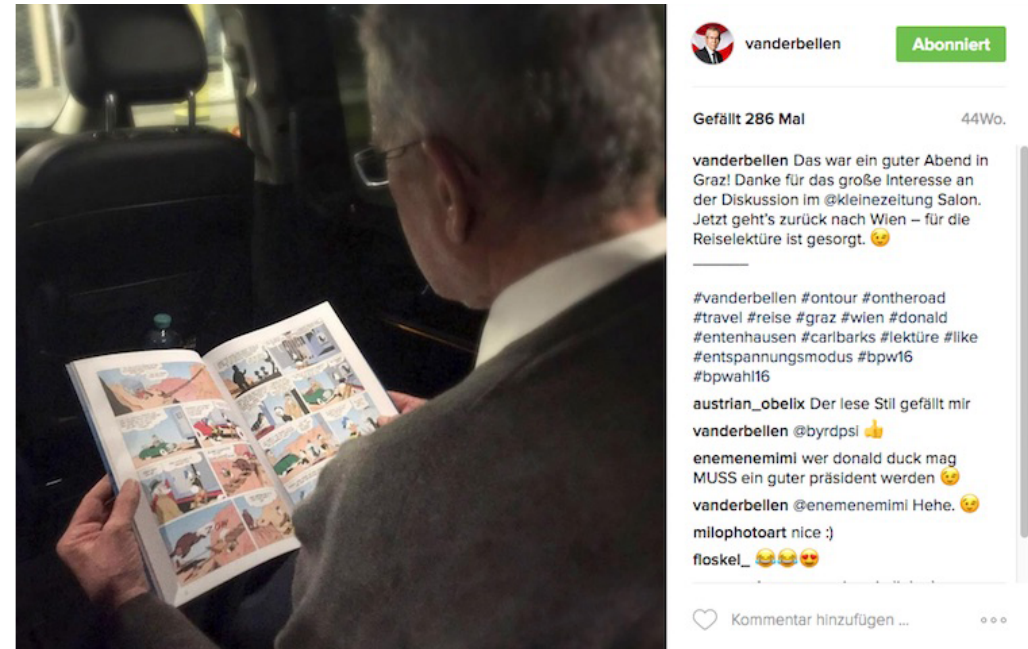
Figure 4. Reading a Donald Duck comic book, posted on 11 April